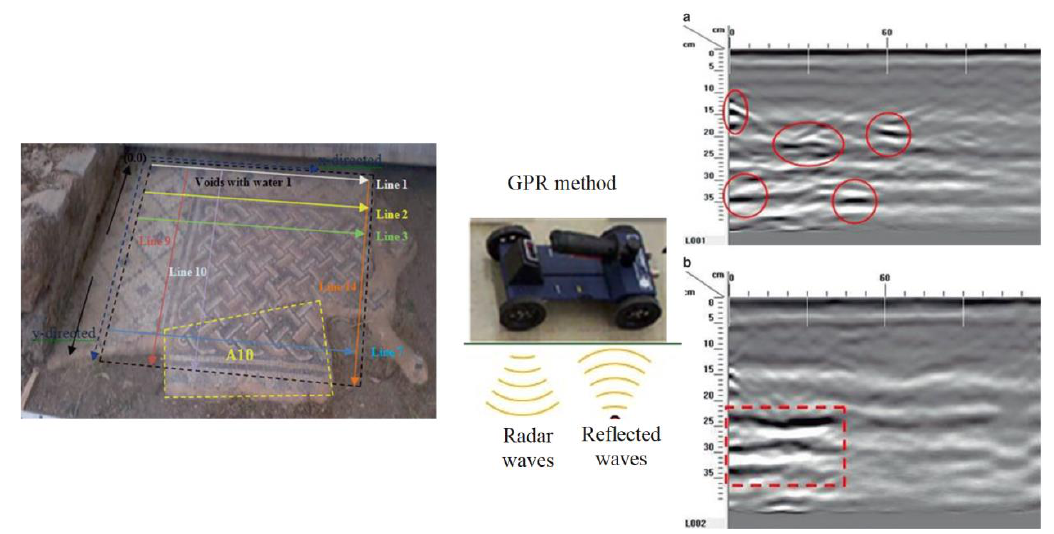
Figure 11. The 2D radar acquisition along single profile lines in the x and y directions of the mosaic ( left ), 2D radar profiles acquired along x - direction line 1 ( a ) and line ( b ) ( right ). Discontinuities in the medium over a depth of 0.10 to 0.35 m are highlighted with red lines. (Reprinted with permission from Ref. [24]. Copyright: 2017 Ftikou, Ε .; Theodorakeas, P. ; Cheilakou, Ε . ; Koui, Μ .).